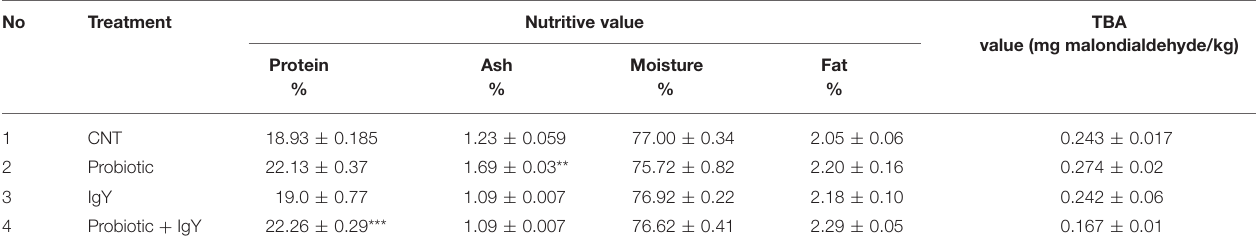
TABLE 5 | Nutritive and TBA values of broiler meat in the experimental